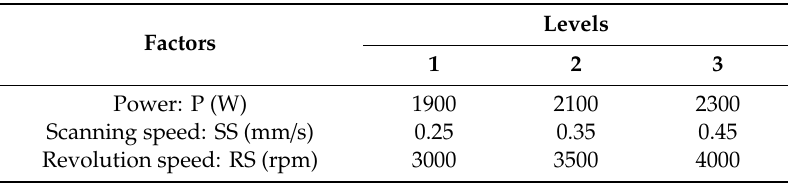
Table 4. Factors and levels for experimentation.